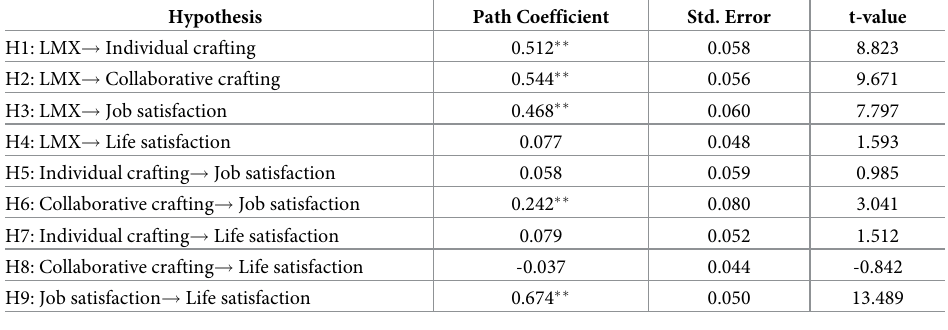
Table 3. Path coefficient of structural model.